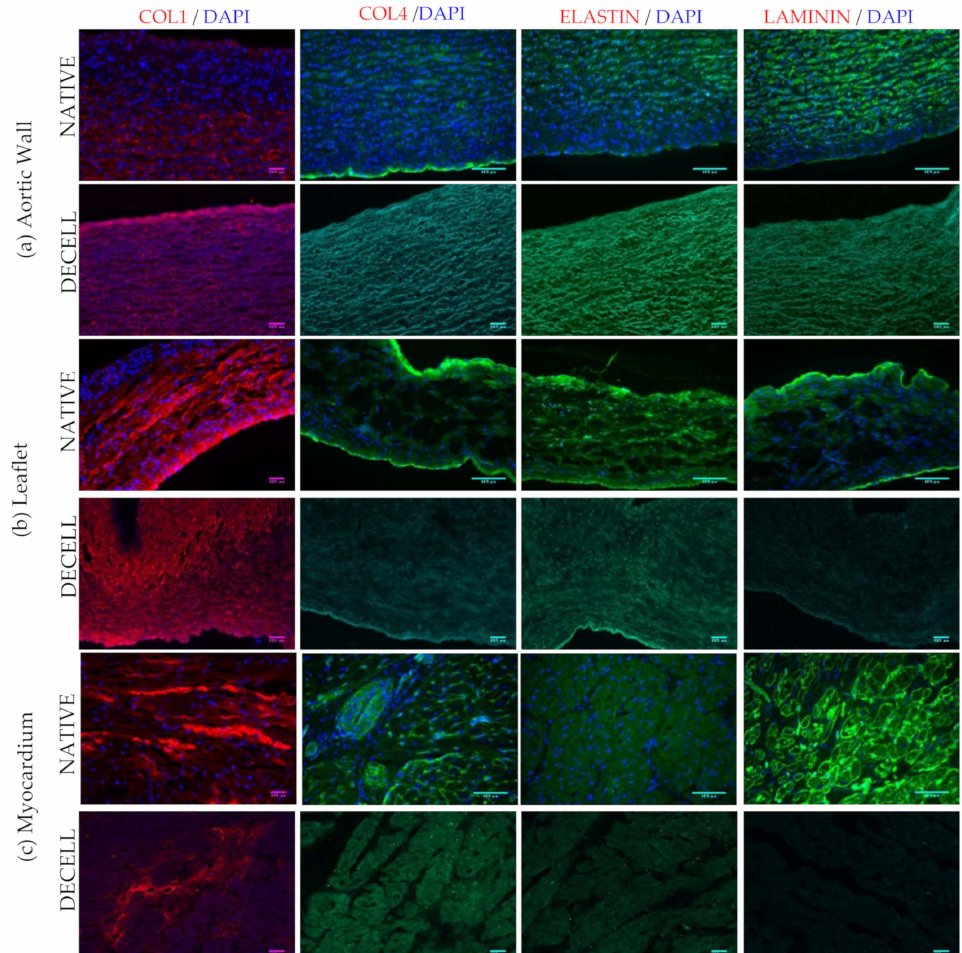
Figure 5. Immunofluorescence analysis showed the PFA fixed cryosections stained with primary and secondary antibodies and DAPI (blue). ( a ) aortic wall, ( b ) leaflets, and ( c ) myocardium. The repre- sentative images indicate the expression of collagen I (red), collagen IV (green), elastin (green) and laminin (green). Images were taken with the Leica imaging system at 20 ×